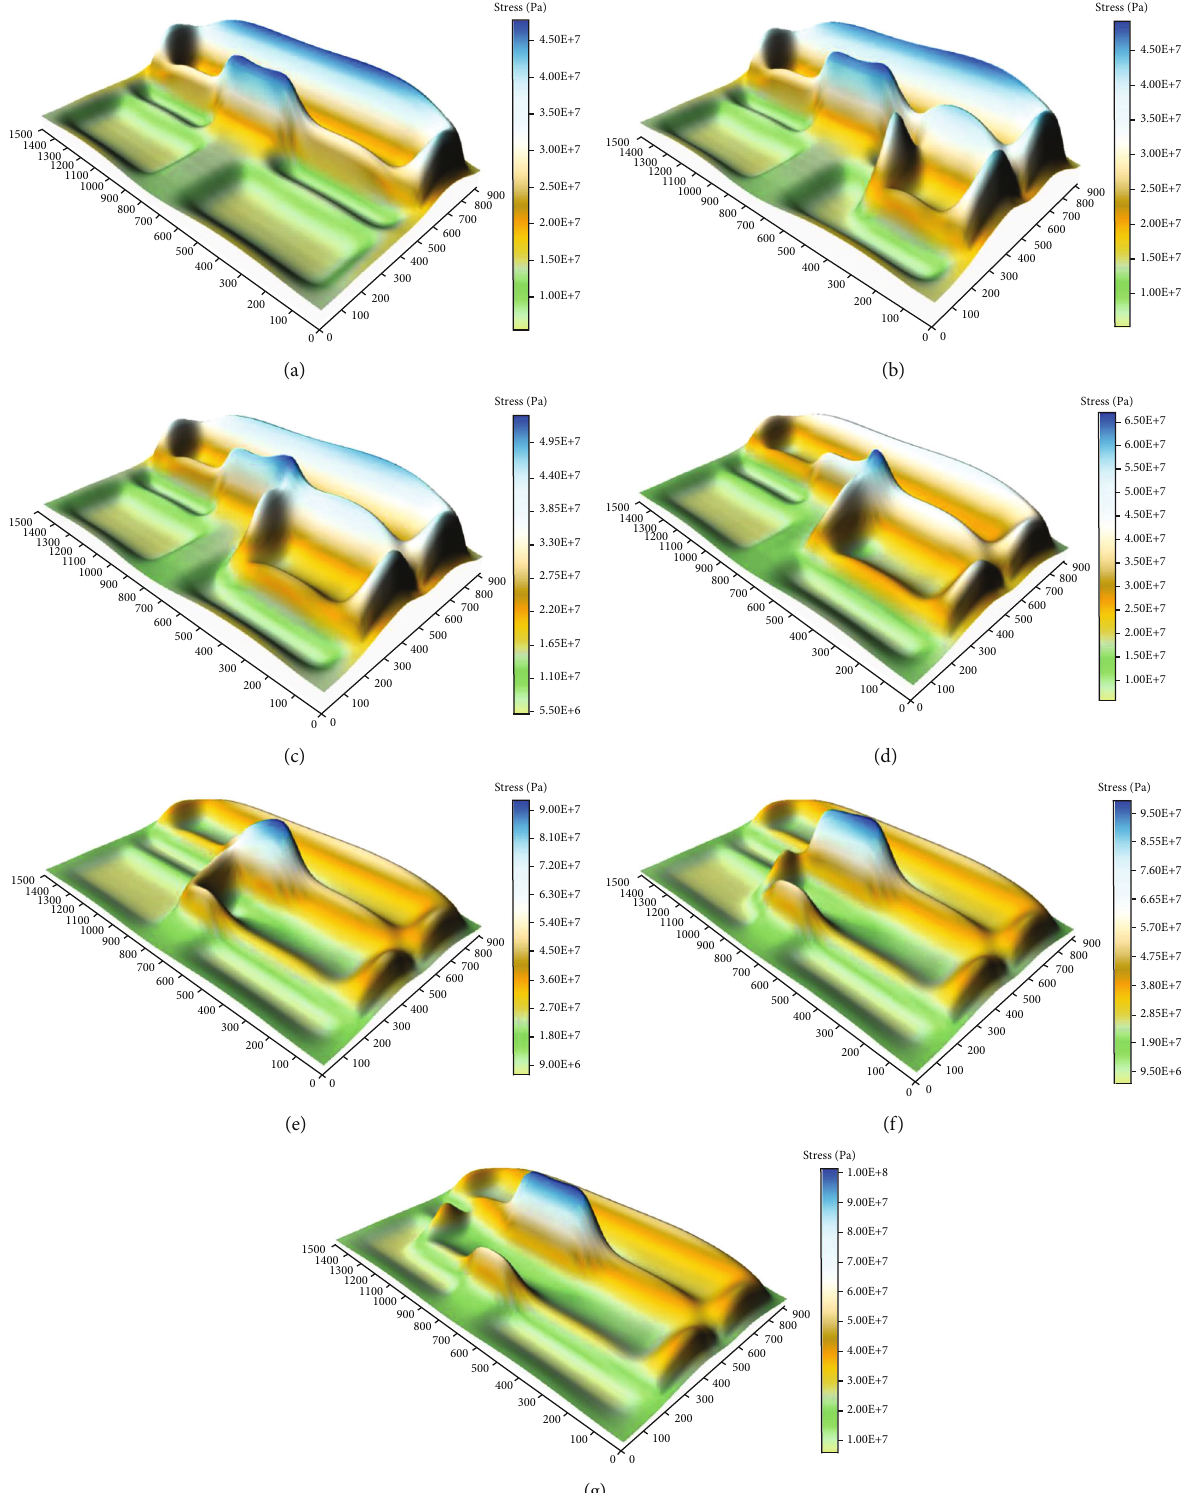
Figure 6: Abutment pressure of 4-2# coal seam. (a) 42107 working face mining 0m. (b) 42107 working face mining 400m. (c) 42107 working face mining 550m. (d) 42107 working face mining 700 m. (e) 42107 working face mining 800m. (f) 42107 working face mining 1000m. (g) 42107 working face mining 1200